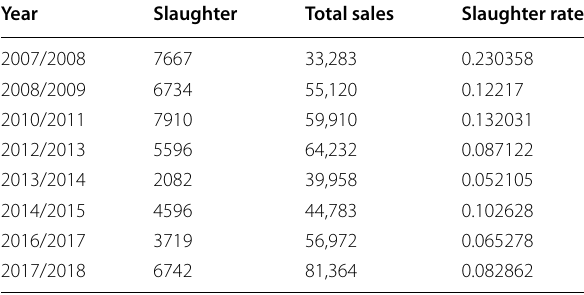
Table 2 Live camel sale and domestic slaughter in